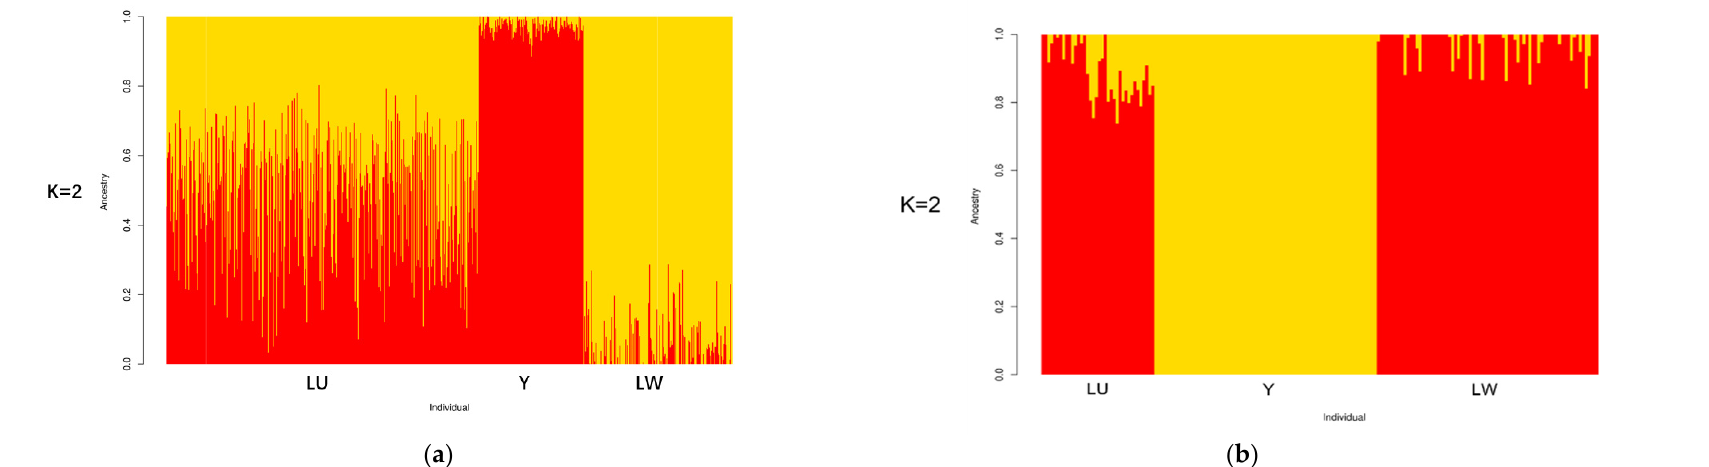
Figure 3. Structure results of ancestry compositions with the assumed number of ancestries at K = 2: ( a ) structure results of LU pig population by SNP chip; ( b ) structure results of LU pig population by GGRS.